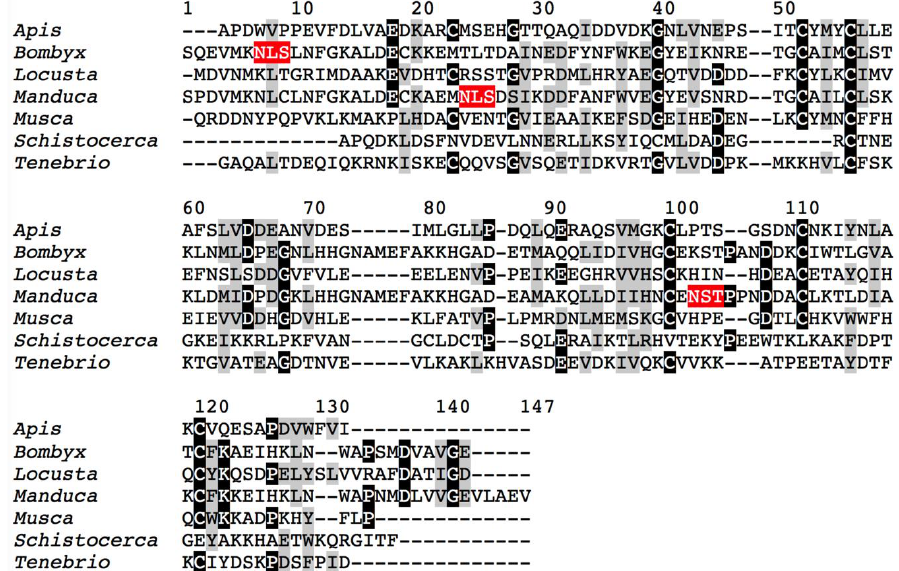
Figure 5. Multiple alignment of 12 kDa HLP and OBP (odorant bindin proteins) from the edible insects Apis mellifera , Bombyx mori, Locusta migratoria, Manduca sexta, Musca domestica, Schistocerca gregaria, and Tenebrio molitor . Identical amino acids residues are in black boxed white letters whereas structurally homologous residues are grey boxed. Putative N -glycosylation sites are colored red.